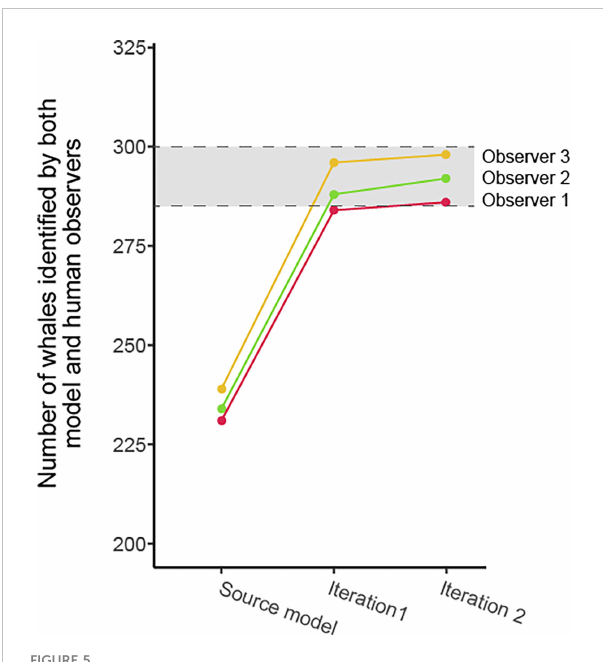
FIGURE 5 Evolution of the observer – model whale detection agreement on the test subset through the model training iterations. The shaded area between hash lines indicates the inter-observer minimum and maximum whale detection